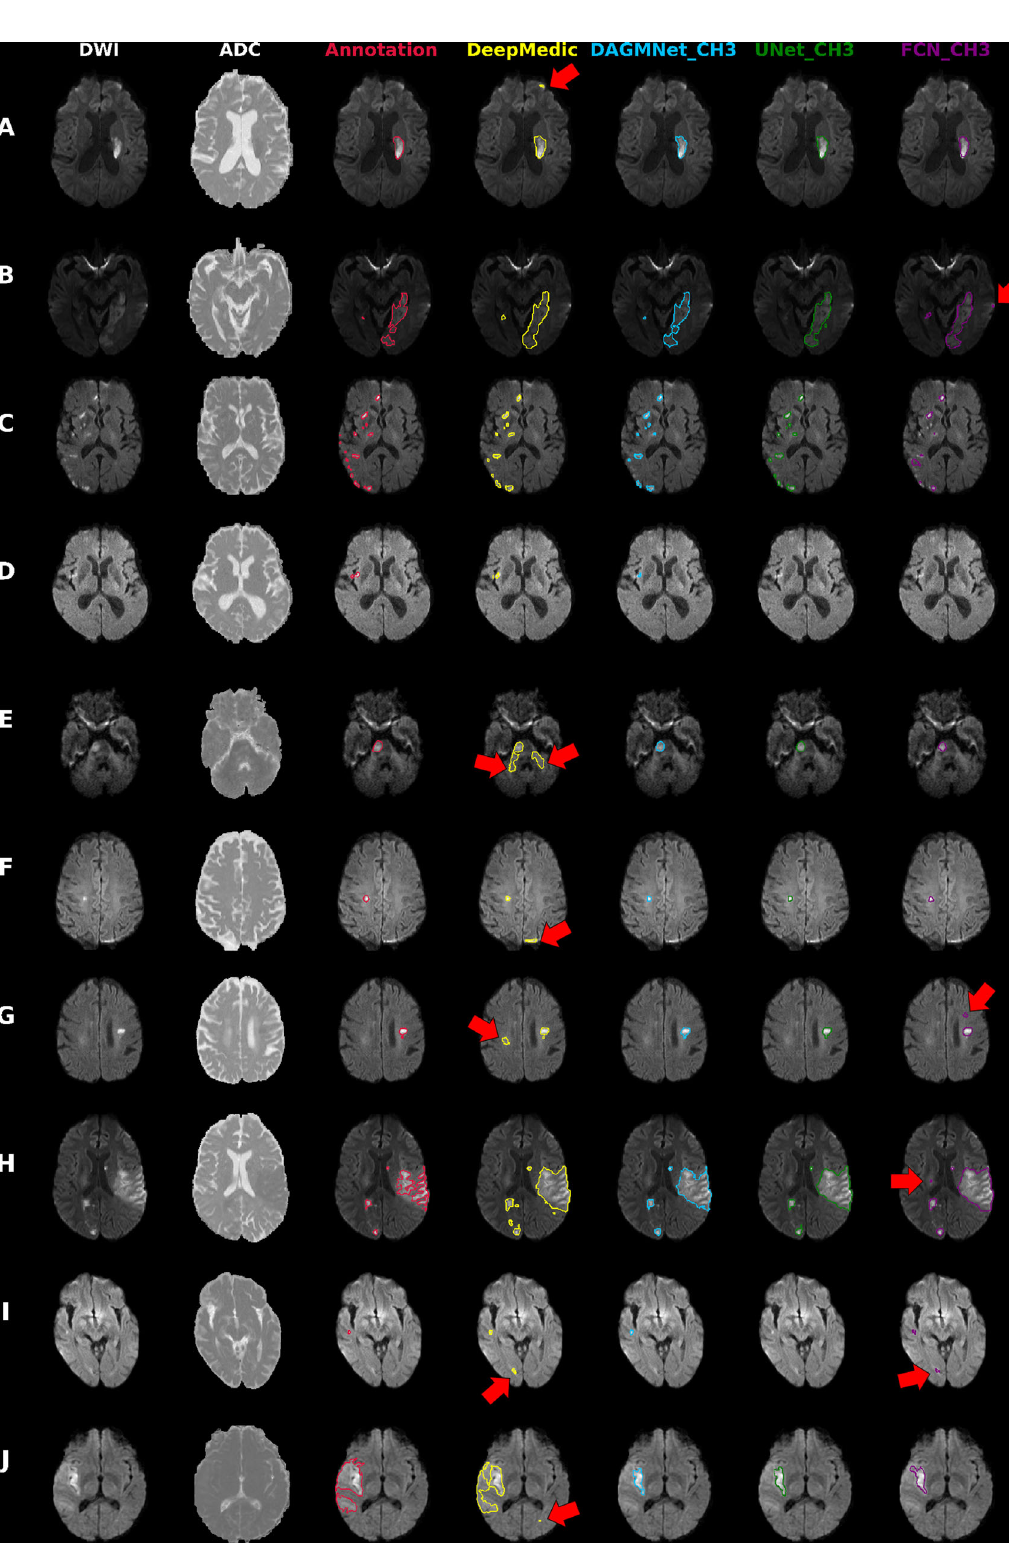
correlation between the contrast of the predicted lesion and the human-de fi ned lesion, indicating the highest agreement with human evaluation. Still, we noticed circumstantial disagreements of our method with the human evaluators in 24 cases (5% of the testing set), in which the retrospective radiological evaluation favored the results of the automated segmentation,